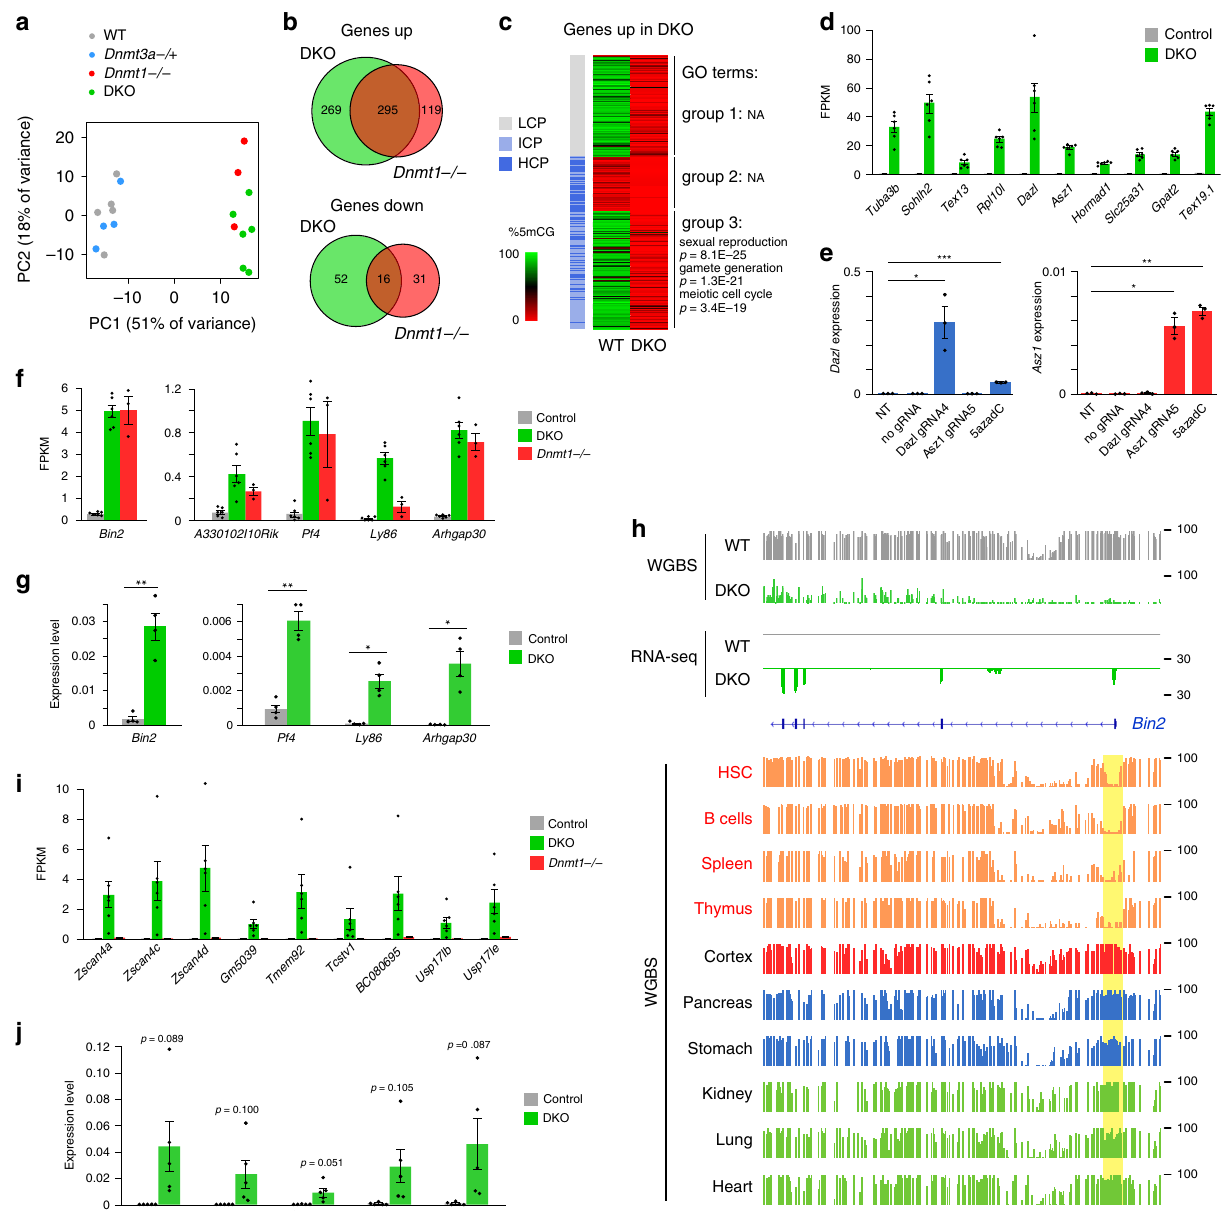
Fig. 4 Transcriptome analysis of Dnmt mutant embryos. a Principal component analysis of RNA-seq data. b Venn diagram comparing the lists of upregulated and downregulated genes in Dnmt1 − / − and DKO embryos. c Heatmap of the three groups of genes upregulated in DKO embryos classi fi ed by their promoter class (LCP low CpG promoter, ICP intermediate CpG promoter, HCP high CpG promoter) and promoter methylation in WT embryos (measured in − 1000 to + 500 bp from the TSS). Group 1: LCP; Group 2: ICP or HCP and promoter methylation < 30%; Group 3: ICP or HCP and promoter methylation ≥ 30%. Gene ontology (GO) terms enriched in each group are shown on the right. d Expression levels (FPKM) of germline genes in DKO and control embryos (mean ± SEM, n = 6 embryos). e RT-qPCR expression levels of Dazl and Asz1 in non-transfected MEFs (NT) and MEFs expressing dCas9- Suntag-TET1 with no gRNA or a gRNA targeting the Dazl or Asz1 promoter (mean ± SEM, n = 3 independent experiments). Cells treated with 0.5 μ M 5-Aza- 2 ′ -deoxycytidine (5azadC) for 72 h were used as control. * p < 0.05; ** p < 0.01; *** p < 0.001 (two-tailed unpaired t test). f Expression levels (FPKM) of lineage-committed genes in DKO, Dnmt1 − / − and control embryos (mean ± SEM, n = 6 embryos for control and DKO, n = 3 for Dnmt1 − / − ). g RT-qPCR analysis of the expression of fi ve lineage-committed genes in control and DKO embryos (mean ± SEM, n = 4 embryos). * p < 0.05; ** p < 0.01; *** p < 0.001 (two-tailed unpaired t test). h Genome browser tracks of RNA-seq and WGBS at the hematopoietic-speci fi c Bin2 gene in WT and DKO embryos and adult tissues 35 – 37 . For embryos, one replicate of RNA-seq and WGBS is shown. The Bin2 promoter (highlighted in yellow) is speci fi cally hypomethylated in hematopoietic tissues (written in red). i Expression levels (FPKM) of 2C-speci fi c genes in DKO, Dnmt1 − / − and control embryos (mean ± SEM, n = 6 embryos for control and DKO, n = 3 for Dnmt1 − / − ). j RT-qPCR analysis of the expression of 2C-speci fi c genes in control and DKO embryos (mean ± SEM, n = 5 embryos). The p values are indicated (two-tailed unpaired t test). Source data are provided as a Source data fi